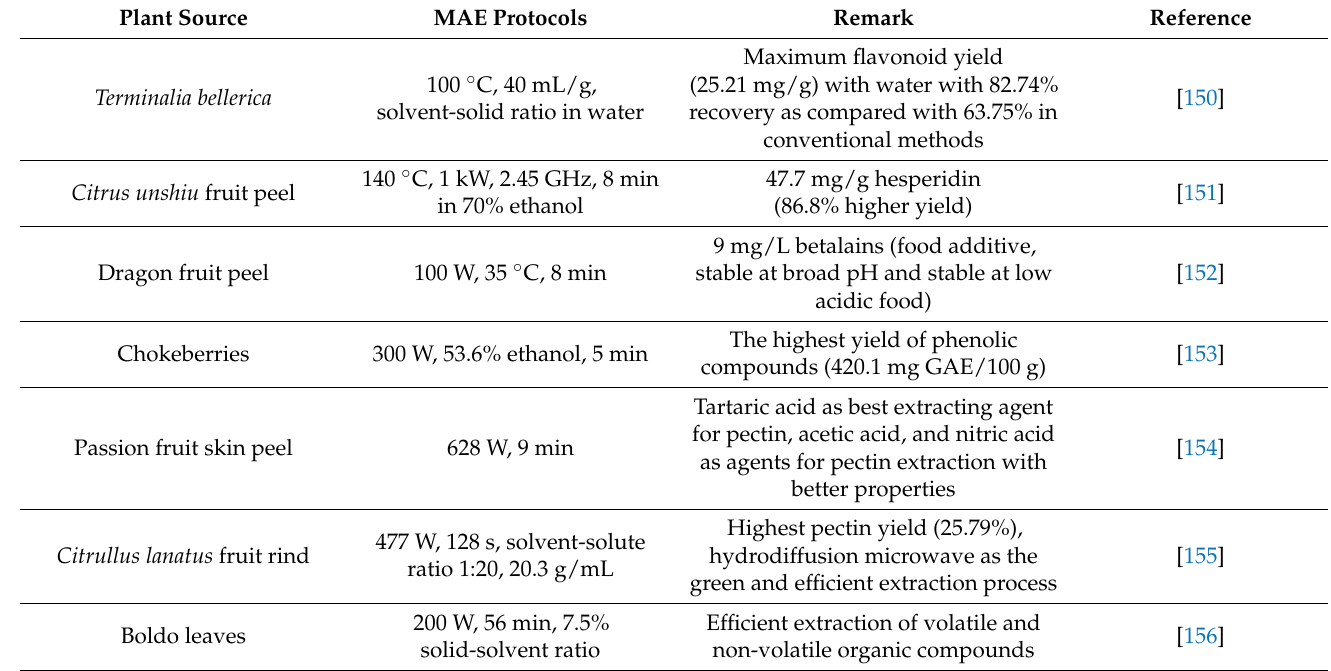
Table 7. Microwave-assisted extraction of bioactive compounds from plant